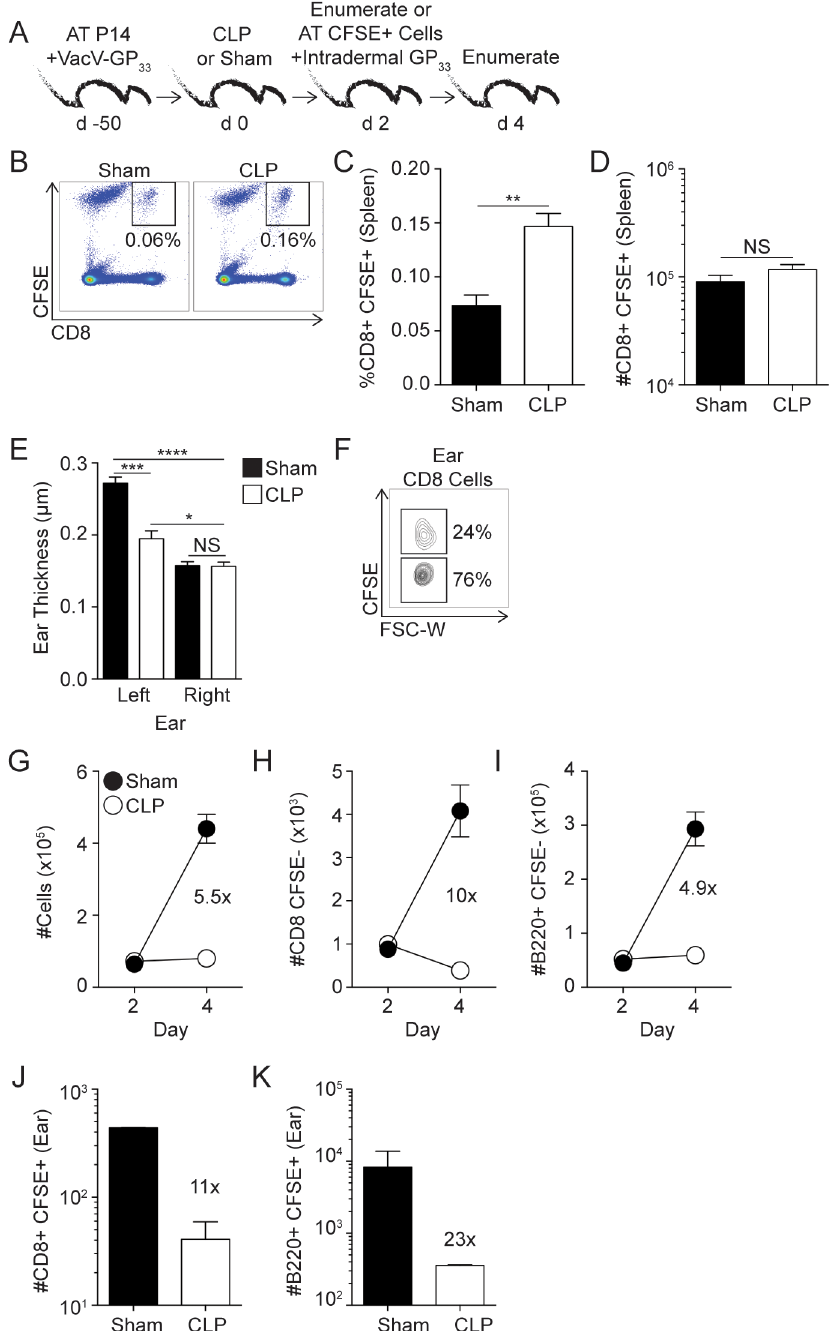
Fig 5. Impairments in bystander recruitment upon skin CD8 T RM activation is not solely due to sepsis- induced numerical loss of circulating cells. (A) Experimental Design. 8 x 10 3 Na ï veP14 CD8 T cells (Thy1.1) were adoptively transferred into C57Bl/6 recipienthosts (Thy1.2) followedby VacV-GP 33 infection of the left ear. After 50 days mice underwent CLP or sham surgery. Mice received intravascular injectionof CD45.2mAb 2 days later and three minutes later cells within the left ear were enumerated to determine baselinecellularity. Another group of VacV-immune mice receivedadoptivetransfer of 14 × 10 6 CFSE-labeled splenocytes from LCMV-immune donor mice and intradermal injectionof 50 μ gof GP 33-41 peptidein the left ear performed to activate GP 33 -specific skin T RM . Mice receivedintravascular injectionof CD45.2mAb 2 days later. Tissues of interest were harvested3 minutes later and analyzed.(B) Representative gating of CFSE